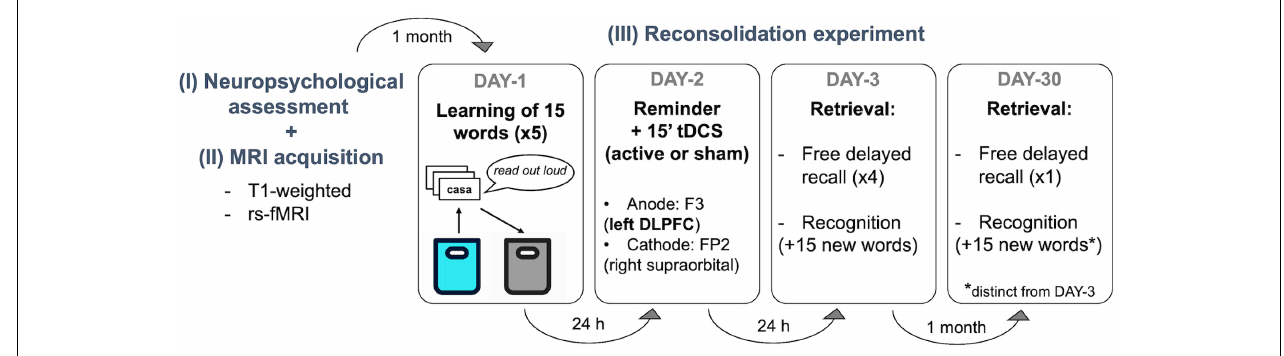
FIGURE 1 | Experimental design. Participants visited our center 6 times in 2 months. The first visit was a (I) basic neuropsychological assessment followed by an (II) MRI acquisition session underwent during the same day or week. (III) The experimental protocol started one month later. There were 3 sessions separated by 24 h (DAY-1, DAY-2, DAY-3) and a follow-up assessment 1 month later (DAY-30). Verbal episodic memory learning was performed on DAY-1, stimulation was applied during 15 min after a contextual reminder on DAY-2, and delayed recall and recognition were measured 1 day after the stimulation session (DAY-3) and at 1-month follow-up (DAY-30). No information was given regarding the two retrieval sessions (i.e., DAY-3 and DAY-30). rs-fMRI, resting state functional resonance imaging; tDCS, transcranial direct current stimulations; DLPFC, left dorsolateral prefrontal